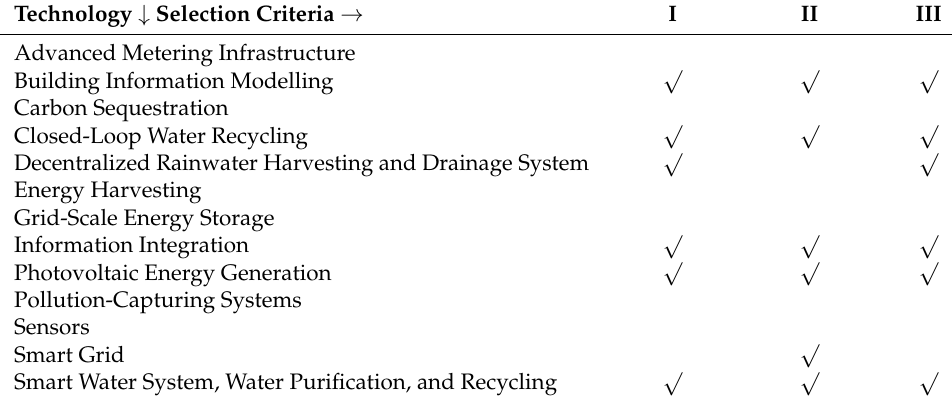
Table 10. Technology evaluation